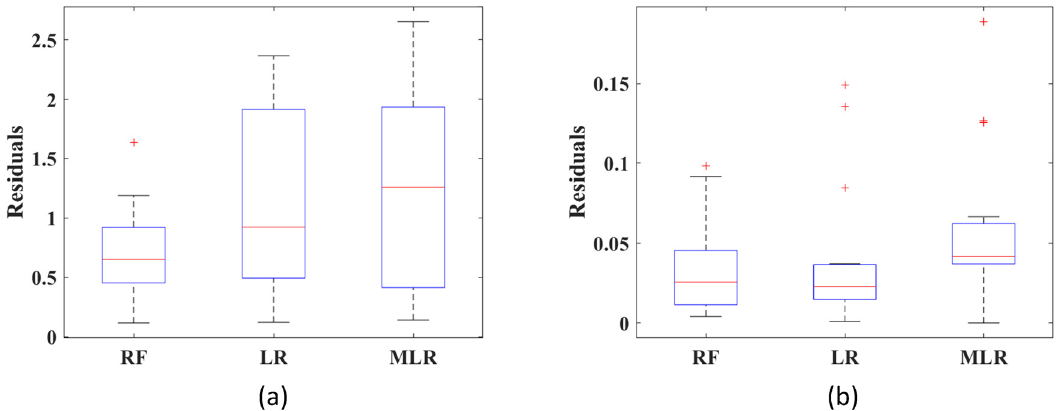
Figure 19: Performance evaluation of three models by ( a ) displacement ductility coe ffi cient prediction boxplot and ( b ) equivalent damping coe ffi cient prediction boxplot.